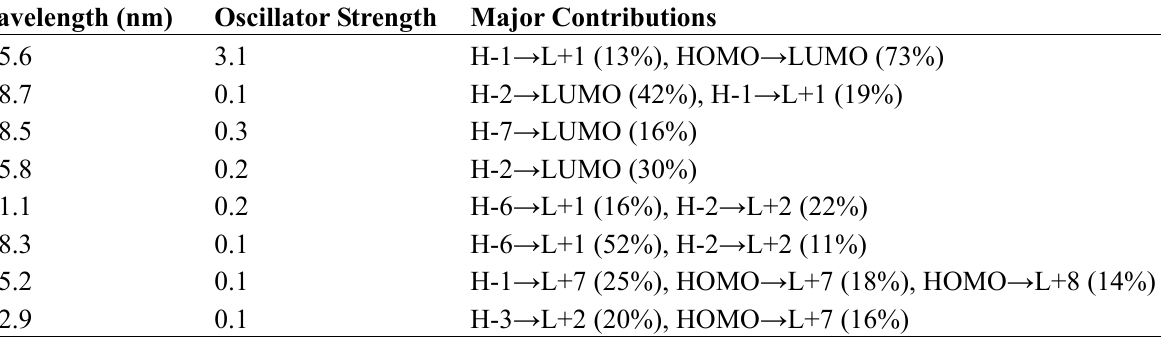
Table 2. Electronic excitations of OIC1MS with oscillator strengths (>0.1) and major contributions (above 10%).